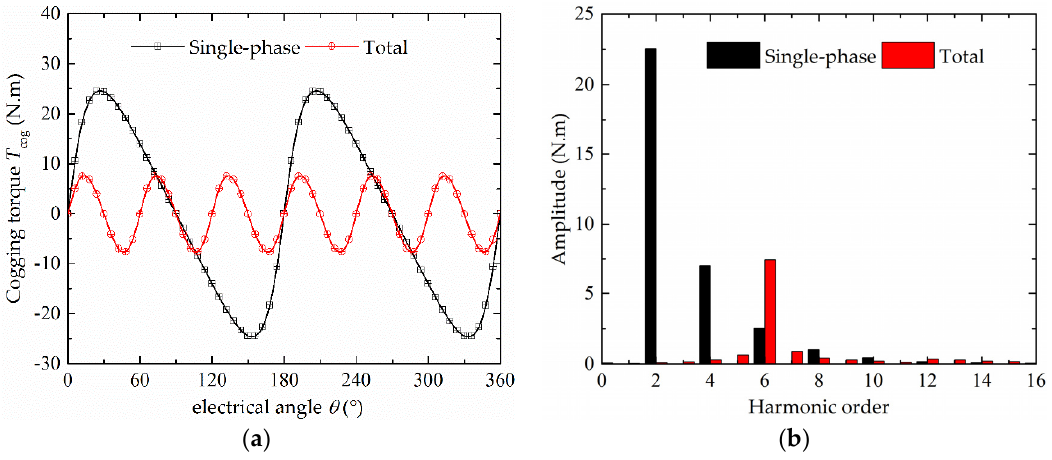
Figure 9. The cogging torque of CS ‐ TFM: ( a ) waveform; and ( b ) harmonic components.